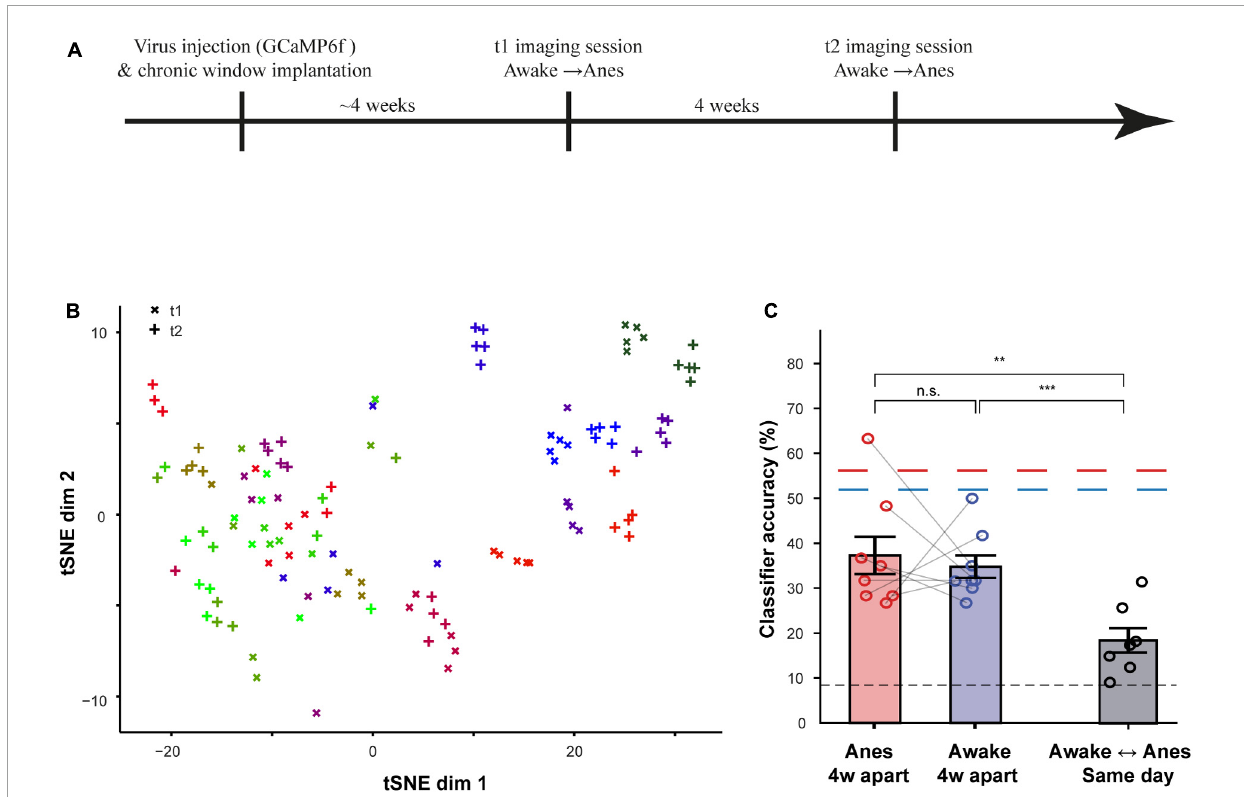
FIGURE7 Odor representations are stable over time. (A) Time-line for the experiment used to assess stability and flexibility of odor representations in both awake and anesthetized states, 4 weeks apart. (B) Odor representation as t-SNE plots across the experiment from one example mouse in two anesthetized recording sessions, 4 weeks apart. (C) The average accuracy of a linear classifier for different training-testing configurations, using data collected in sessions that were 4 weeks apart. Results from the classifier using data collected within the same day are plotted as dashed lines for comparison. Black Dashed line represents chance level. ** p < 0.01; *** p <